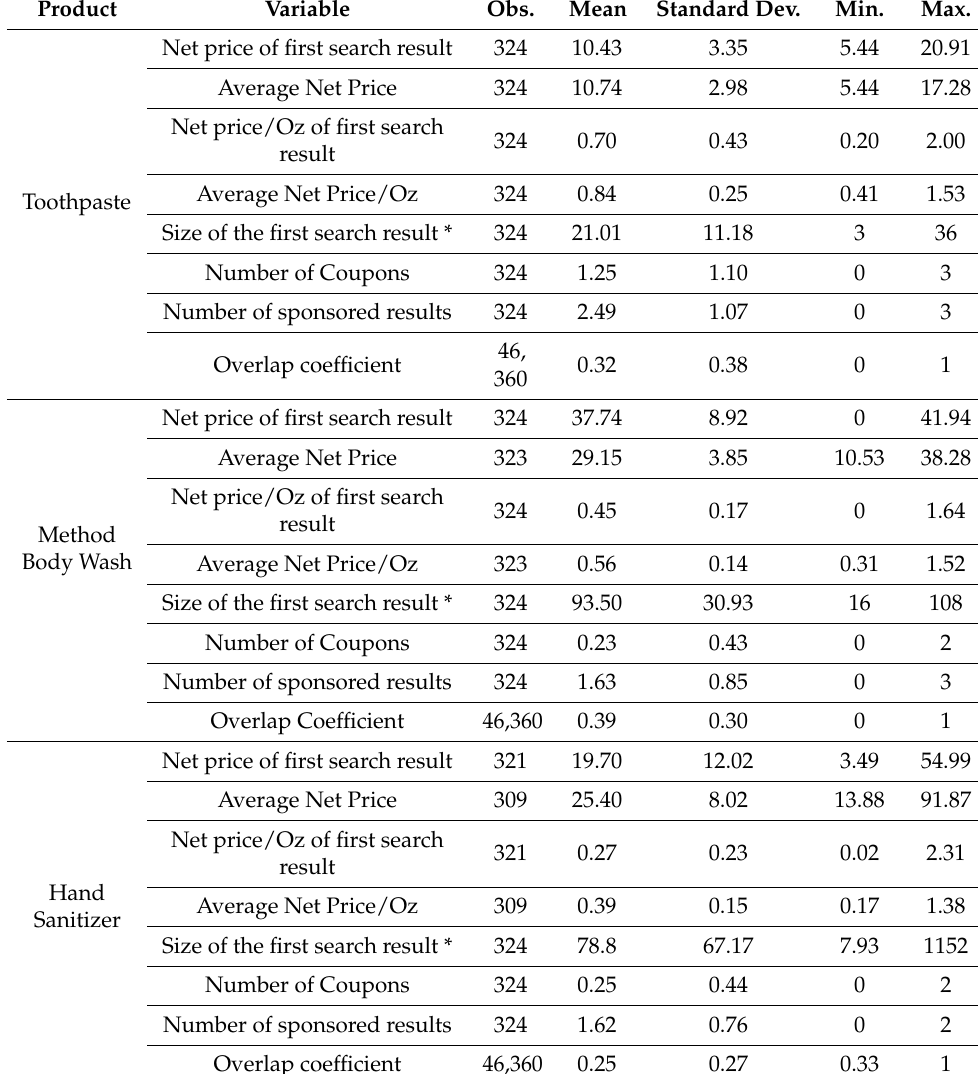
Table 2. Search results summary statistics.